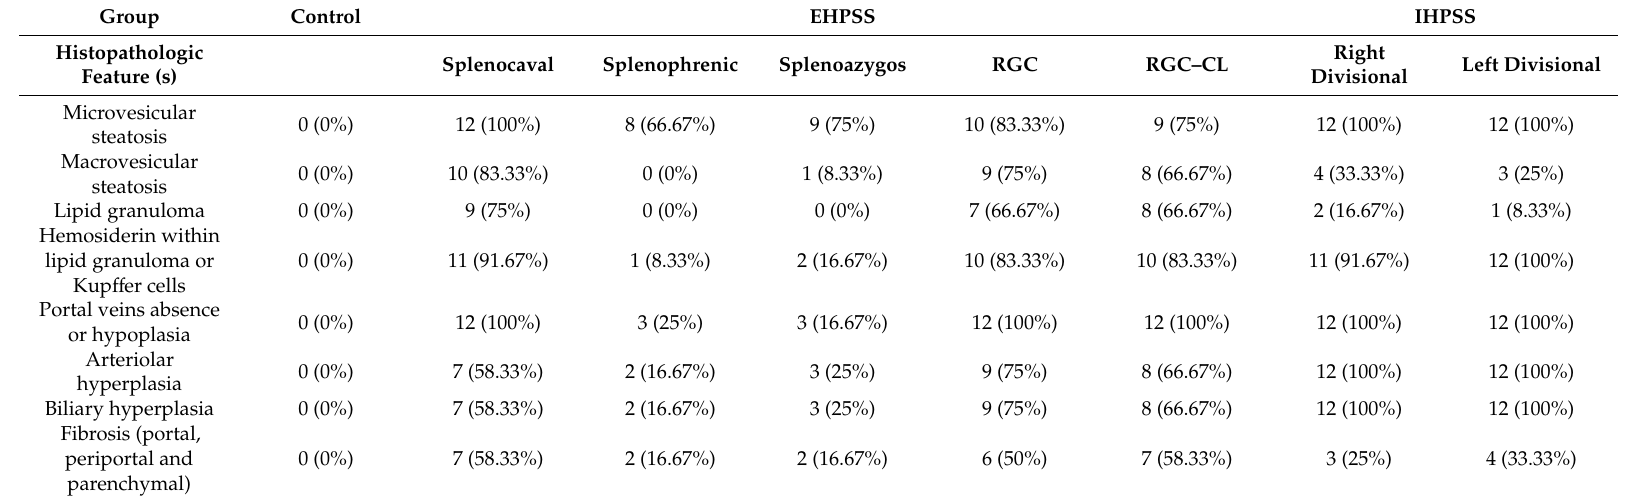
Table 4. Hepatocellular and vascular pathologies in the liver biopsies from dogs a ff ected either with EHPSS or IHPSS, as well as the healthy control ones. Group Control Histopathologic Feature